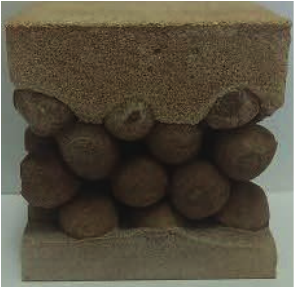
Fig. 13. Variator